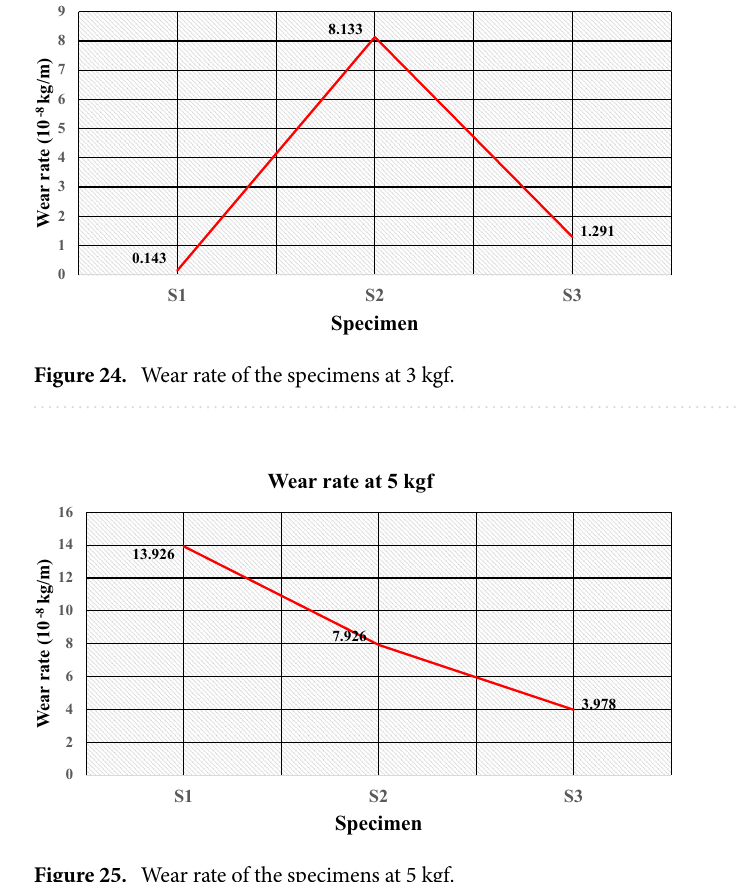
Figure 25. Wear rate of the specimens at 5